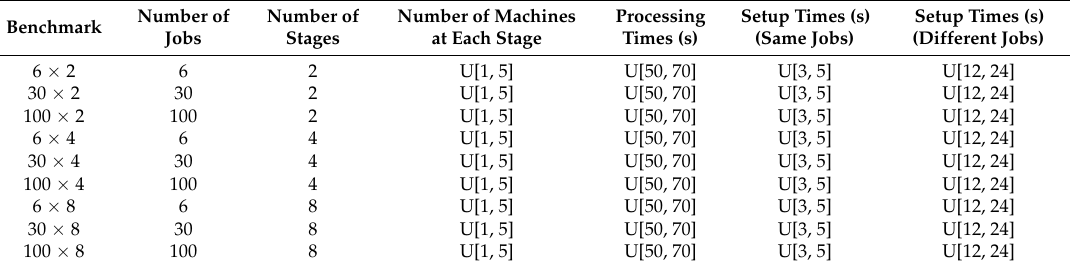
Table 5. Nine benchmarks for dynamic HFS (Hybrid Flow Shop) scheduling.